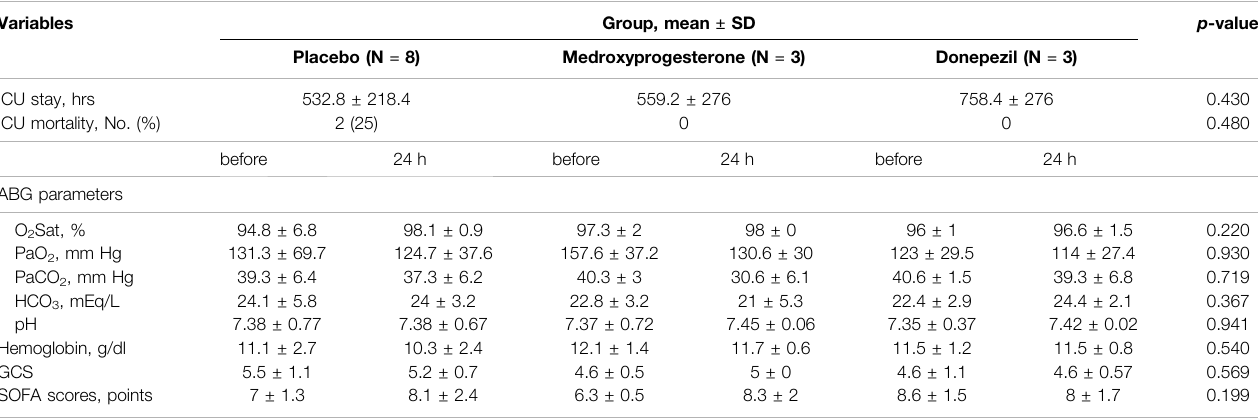
TABLE 4 | Secondary outcomes in non-successfully weaned patients before and after 24 h. Variables